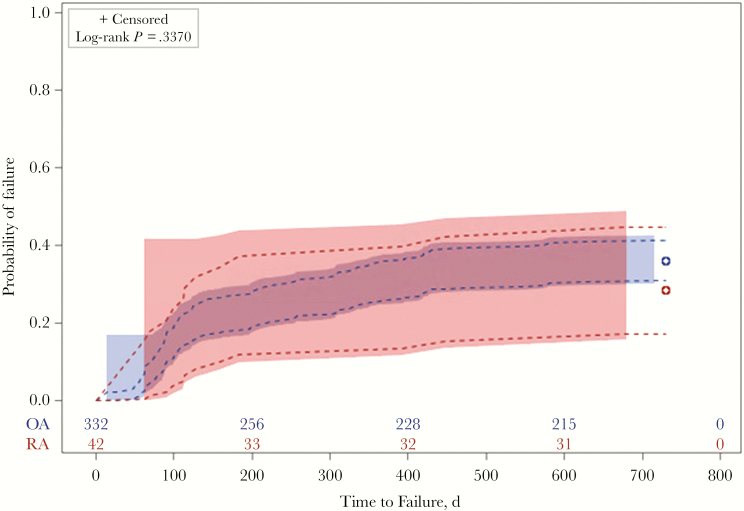
Failure curve for time to microbiological recurrence with or without revision surgery in Staphylococcus aureus prosthetic joint infection patients.